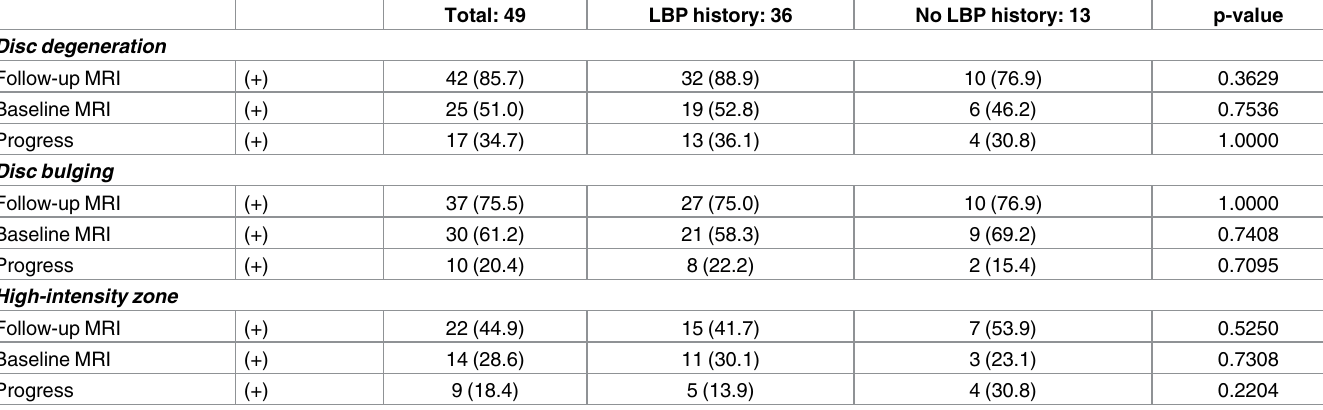
Table 4. Magnetic resonance imaging findings at the follow-up and baseline of patients with and without low back pain history during the 10 years between the baseline and follow-up